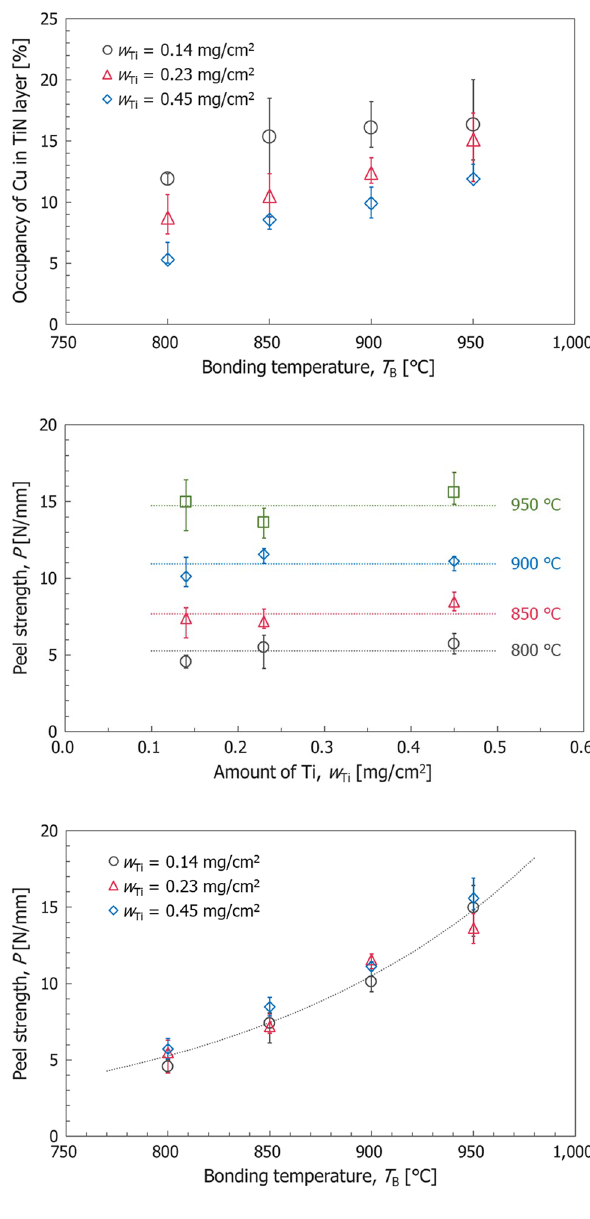
Fig. 7 Peel strength at Cu/ AlN interface as a function of bonding